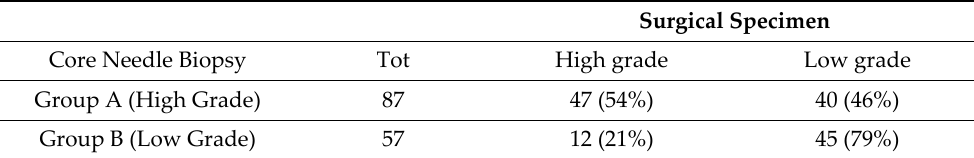
Table 2. Grade Diagnosis of The Core Needle Biopsy Specimen and Surgical